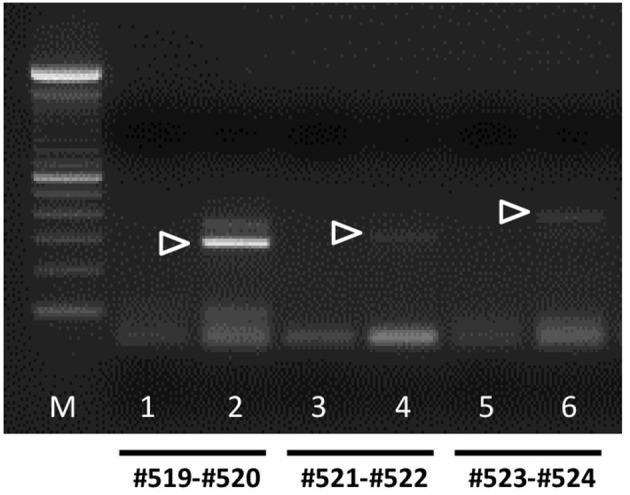
Semi-quantitative RT-PCR analysis for bRXFP2 transcripts of RNA derived from purified bovine oocytes (lanes 2, 4, and 6) compared with water controls (lanes 1, 3, and 5). PCR primers used are shown below the panel. White triangles indicate the position of the correctly spliced PCR product. A 100 bp DNA ladder (M) was used as size markers on the right side of the gel image. PCR conditions (primers, annealing temperature, expected size) as in Figure 6 plus:#523–#524, 62°C, 392 bp.